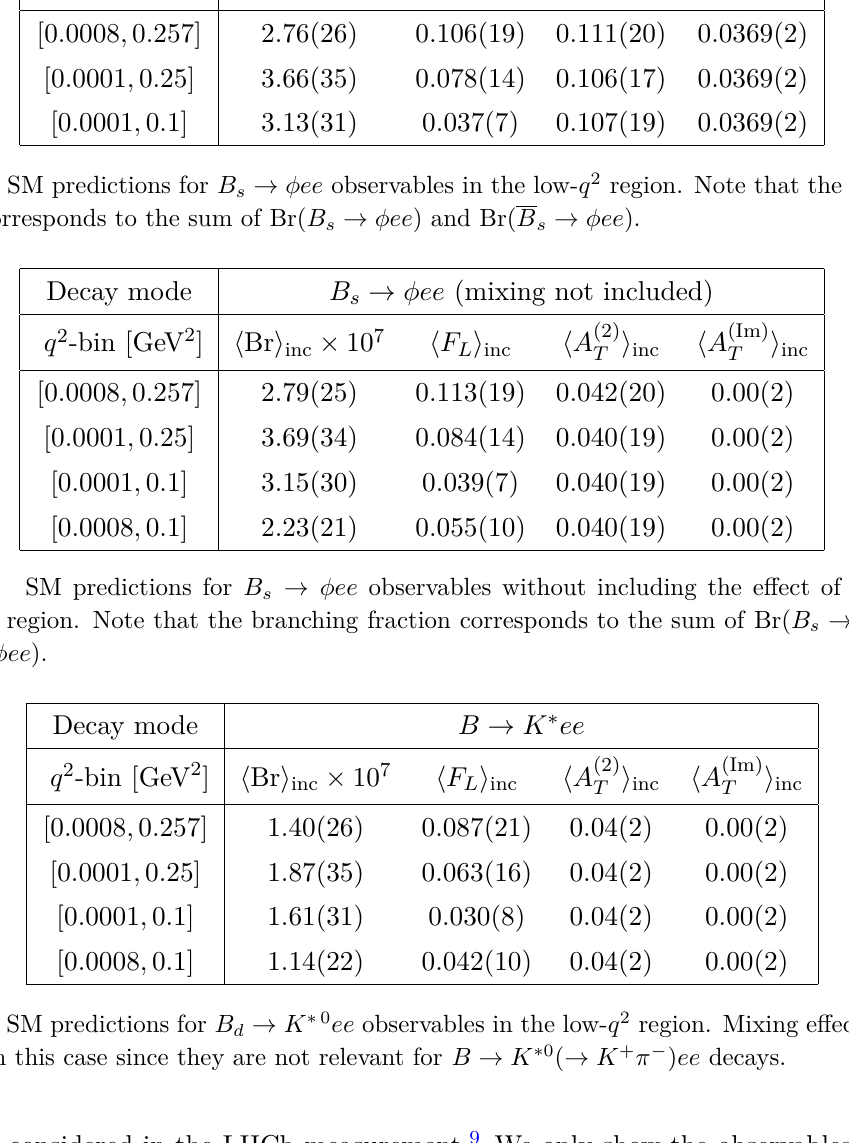
Table 3 . SM predictions for B d → K ∗ 0 ee observables in the low- q 2 region. Mixing effects are not included in this case since they are not relevant for B → K ∗ 0 ( → K + π − ) ee